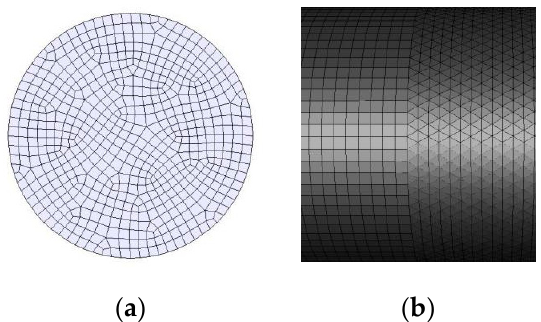
Figure 4. Schematic of mesh generation: ( a ) Meshing of inlet pipe and outlet pipe; ( b ) Meshing of connected sections.